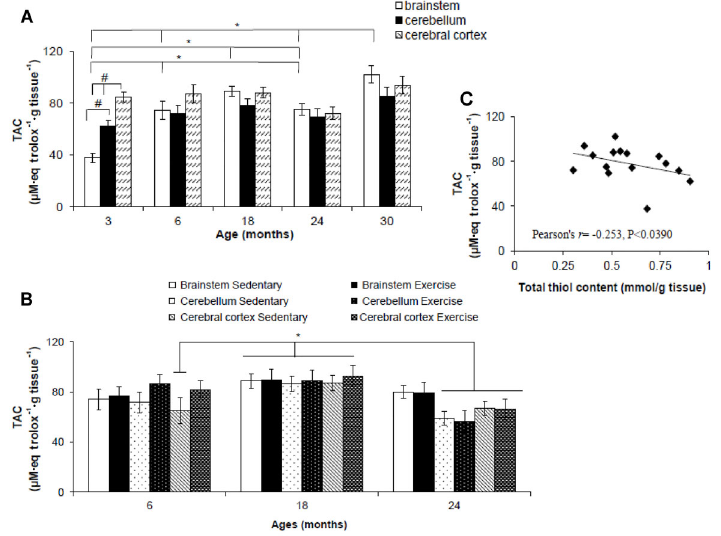
Figure 5. Total antioxidant capacity (TAC) ( A and B ) and correlation between TAC and total thiol content ( C ) in the brainstem, cerebellum, and cerebral cortex of Wistar rats of different ages ( A and C ) and after 12 weeks of treadmill running ( B ). Data are reported as means ± SE. *P o 0.05, two- or three-way